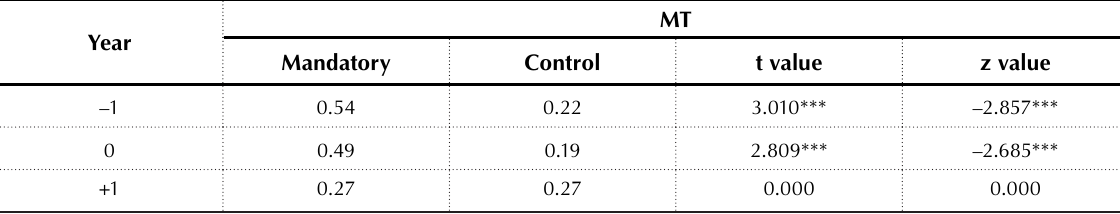
Table 1. Management turnover in mandatory restatement firms versus control firms